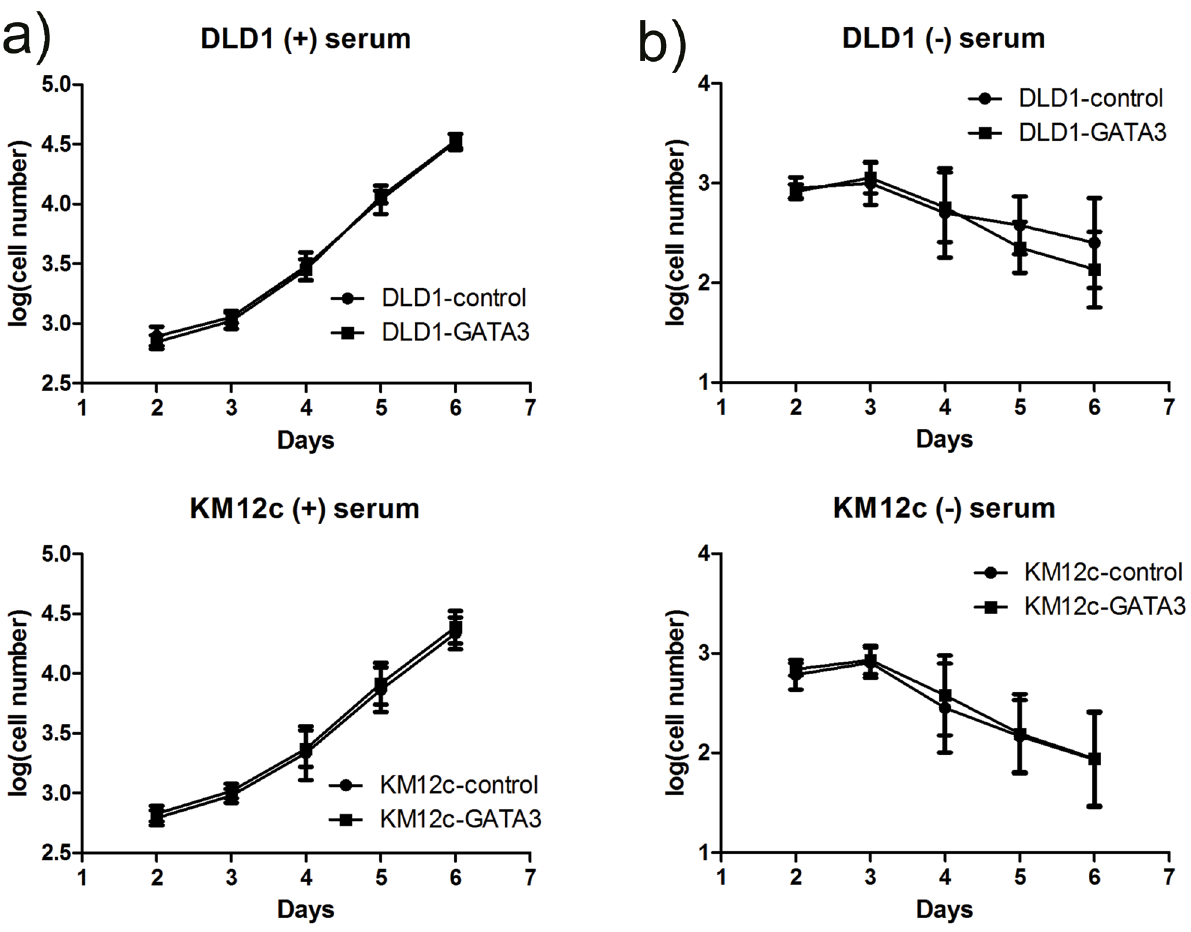
Supplemental Figure 5. GATA3 does not affect 2D CRC proliferation. Growth curves (log base 10 of the cell number) from CRC cell lines grown in the presence of 10% serum ( a, “(+) serum)”) or the absence of serum ( b, “(-) serum”). Cells were plated in triplicate and imaged on a Cellavista automated microscope in 3 independent experiments. Mean is plotted and error bars represent 95% confidence intervals. No significant differences were observed between control and GATA3-OE cells for either cell line.